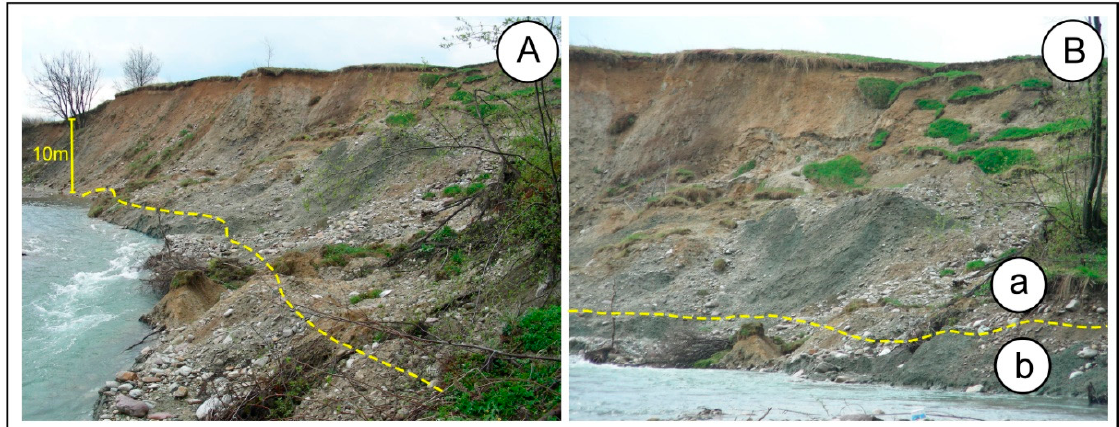
Figure 8. Colluvium composed of gravel with silt and mudstone with clay ( A ) overlying the undis- turbed foundation ( B ) of Neogene clayey mudstones in Chocho ł ów (1) landslide; dashed line marks the trace of the detachment surface; ( a )—colluvium, ( b )—undisturbed (mudstones and claystones) landslides bedrock base